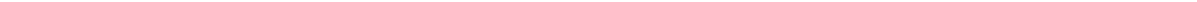
Fig. 5 Structure of the human Gle1 CTD (cid:129) Nup42 GBM (cid:129) DDX19 Δ N53 complex. a Crystal structure of H. sapiens Gle1 CTD (cid:129) Nup42 GBM (cid:129) DDX19 Δ N53 (ADP). Motifs of interest are colored and labeled: auto-inhibitory helix (residues 54 – 67, purple); mobile loop (residues 68 – 91, blue); trigger loop (residues 328 – 335, yellow); anchor loop (residues 390 – 403, cyan); motif VI (residues 429 – 435, light cyan); C-terminal helix (residues 468 – 479, magenta). Boxes indicate the regions shown to the right. b , c Close-up views of critical complex-forming interactions in interfaces 1 and 2. d Left: crystal structure of H. sapiens Gle1 CTD (cid:129) Nup42 GBM (cid:129) DDX19 Δ N53 (AMP-PNP (cid:129) Mg 2 + ). DDX19 is colored magenta for clarity. Right: Superposition of the ADP and AMP-PNP (cid:129) Mg 2 + bound structures. e Analysis of the effect of single amino acid substitutions in the Gle1-DDX19 interface on Gle1-mediated stimulation of DDX19, using the same conditions as in Fig. 4b at 37 °C. Values shown are the average of three experiments. Error bars indicate standard deviation. f Left: crystal structure of S. cerevisiae Gle1 CTD (cid:129) IP 6 (cid:129) Dbp5 Δ N90 (ADP) (PDB ID 3RRN) 10 . Right: superposition of the S. cerevisiae and H. sapiens structures. The arrow indicates the rotation relating the conformations observed in the two crystal structures. Circles highlight structural differences. See also Supplementary Fig.